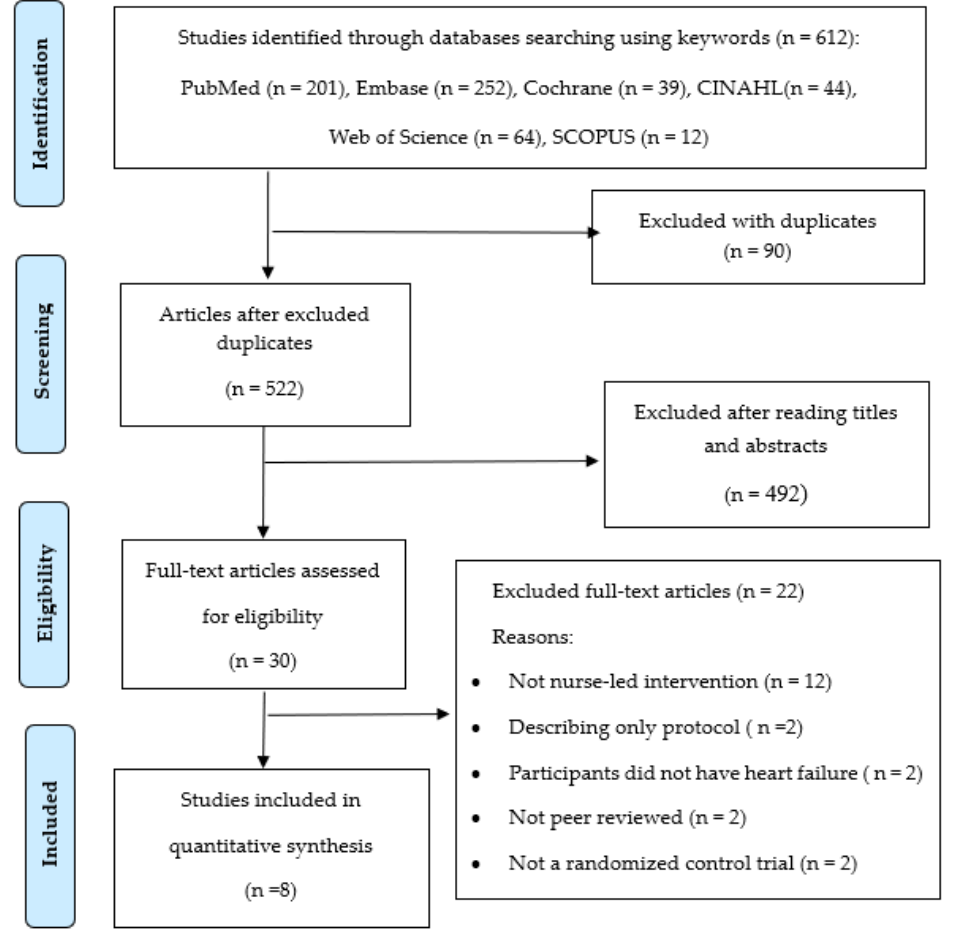
Figure 1. Flow chart of systematic review of literature.